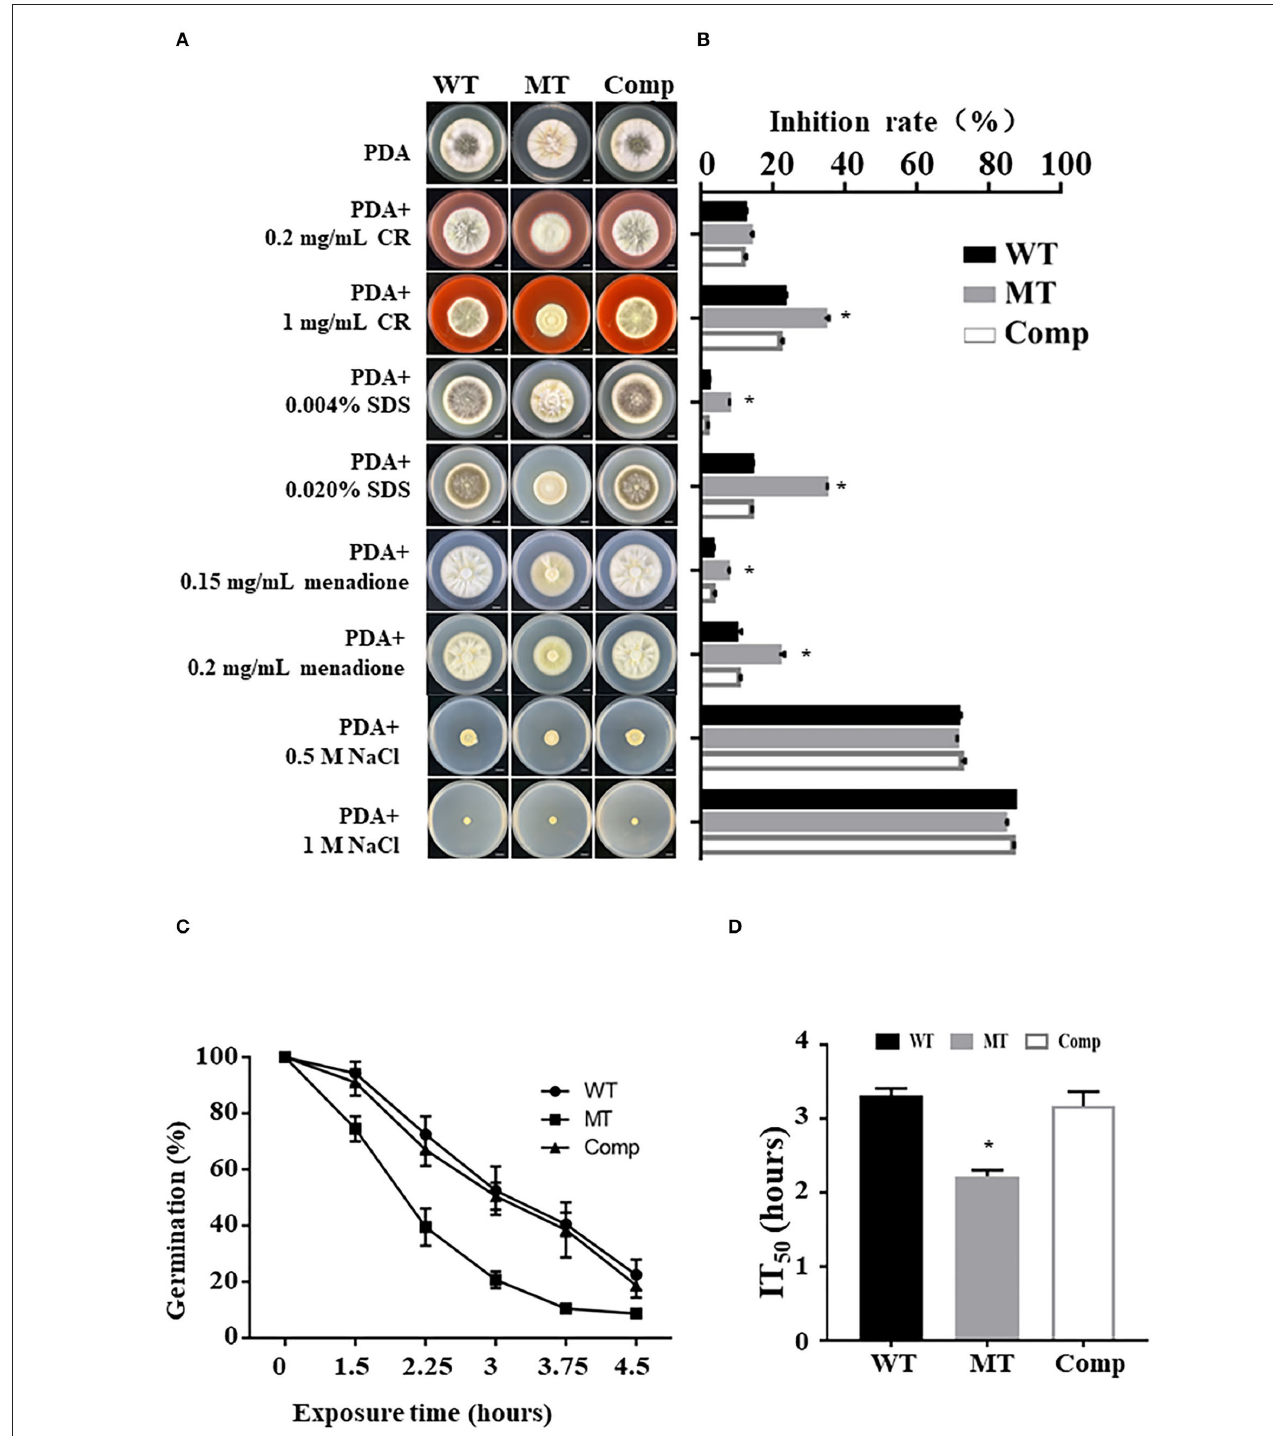
FIGURE 3 | Effect of MrUbp14 disruption on abiotic stress tolerance. (A) Phenotype of colony from relative strains incubated on PDA with chemical stressors. The images were obtained after cultivation at 25 ◦ C for 10 days. Scale: 1cm. (B) The growth inhibition rates of different strains in the chemical stressor. Growth inhibition rate = ( D control - D treated )/ D control ) × 100% (of which, D indicates the colony diameter of relative strains cultured on PDA at 25 ◦ C for 10 days). (C) The percentage of conidial germination for different strains were presented during heat stress. Conidia of relative strains were exposed to 45 ◦ C for different times, and then cultured on PDA at 25 ◦ C for 20h to determine conidial germination. (D) The mean 50% inhibition time (IT 50 ) of different strains under heat treatment. Error bars indicate SD of three biological replicates. The asterisk (*) indicates p < 0.05.